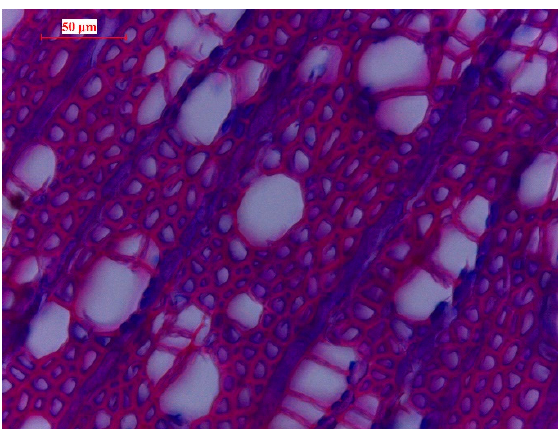
Figure 7. Microscopic images of xylem vessels in small groups in shoot cross-sections.